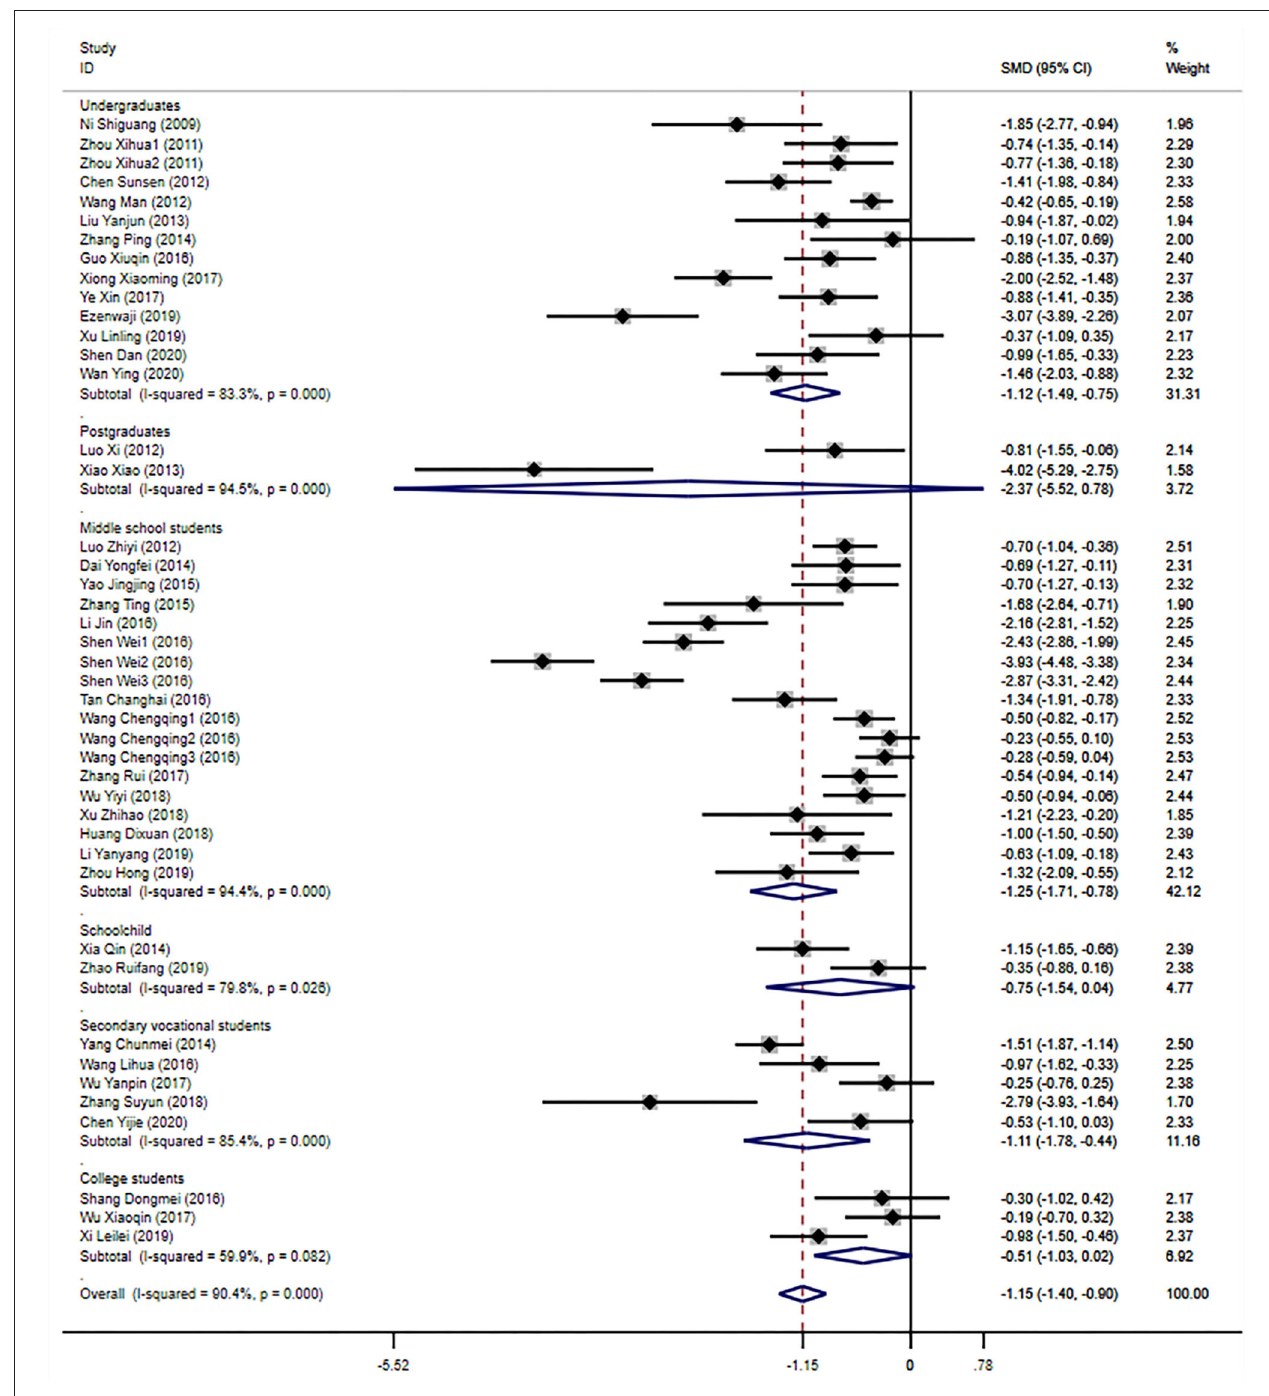
FIGURE 2 | Overall analysis and subgroup analysis based on educational background.